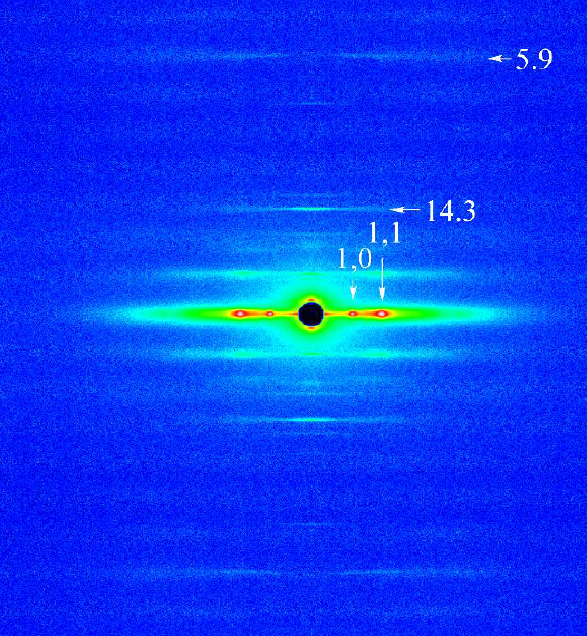
Figure 6. 2D X-ray diffraction patterns from high-Ca-rigor fibers, obtained before ramp-shaped releases. Equatorial (1,0) and (1,1) reflections, meridional 14.3 nm reflection, and 5.9 nm actin-based layer lines are indicated by vertical and horizontal arrows, respectively.